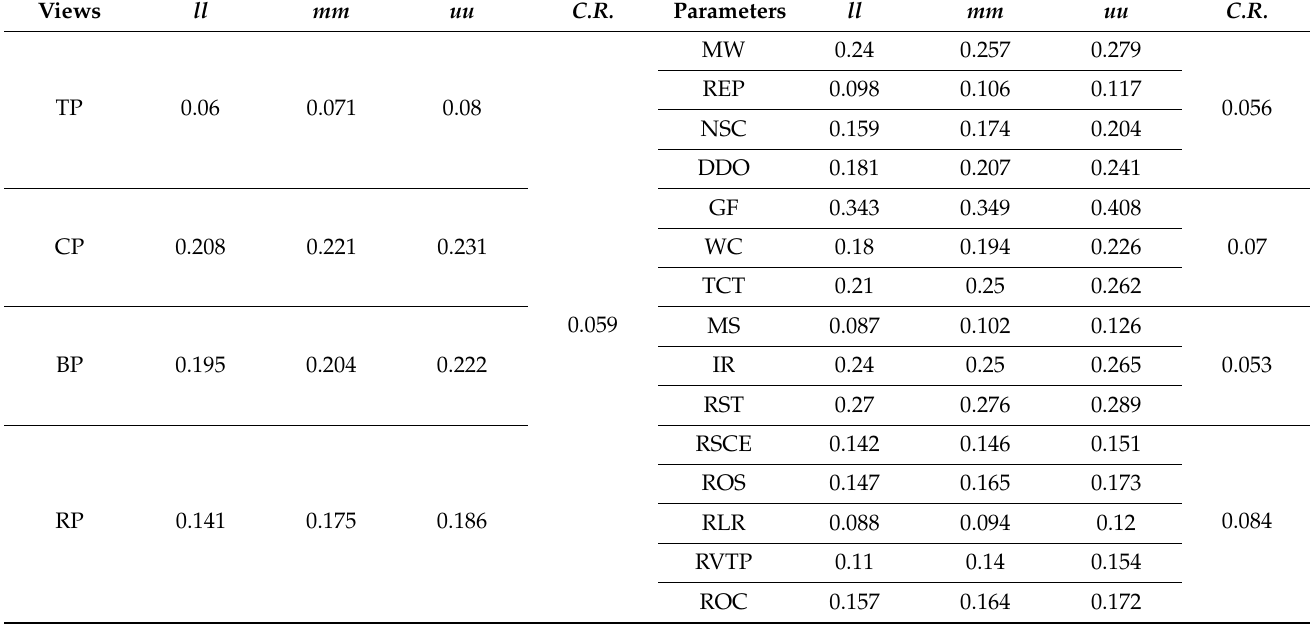
Table 10. The fuzzy weights of views, parameters, and C.R .